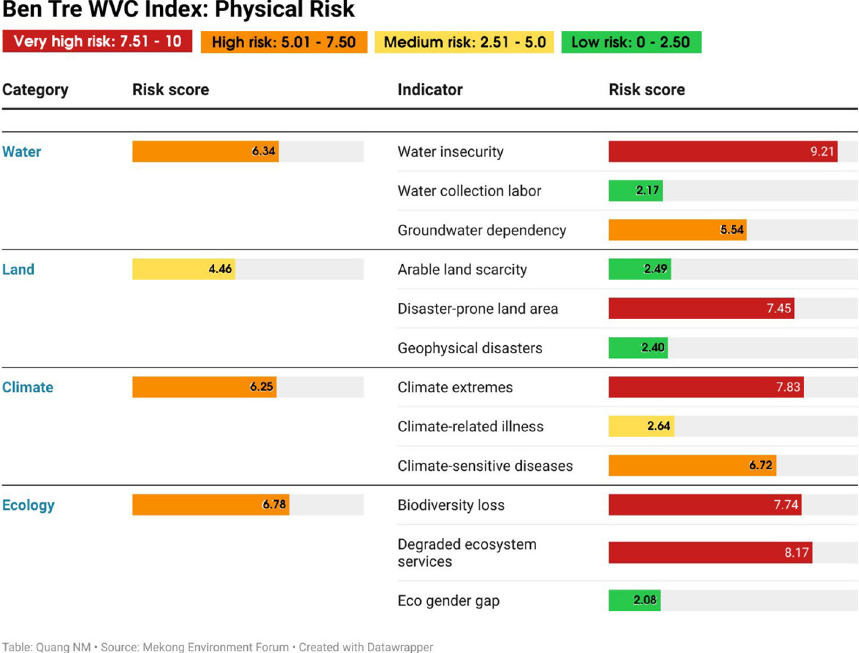
Figure 3. Physical risk